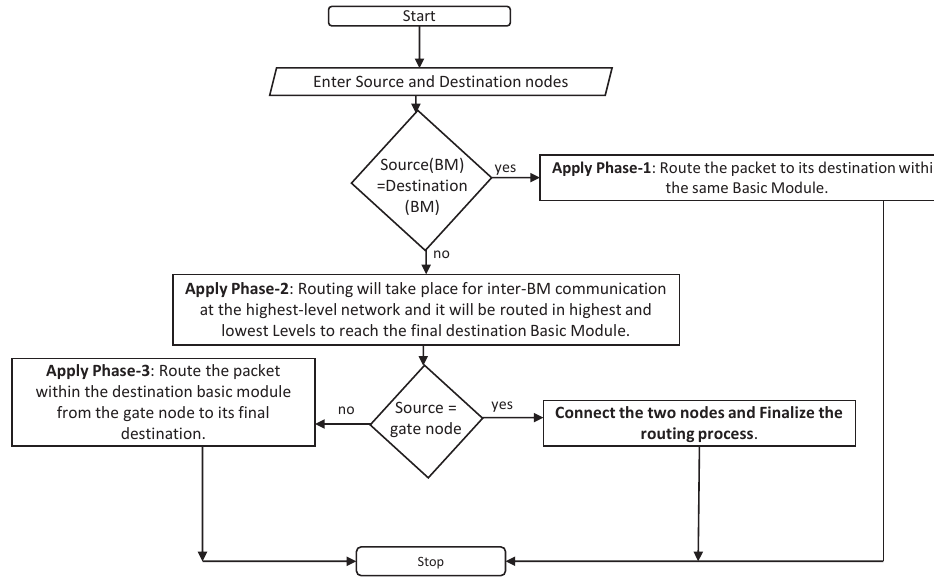
Figure 3. Illustration of Message Routing in a TFBN